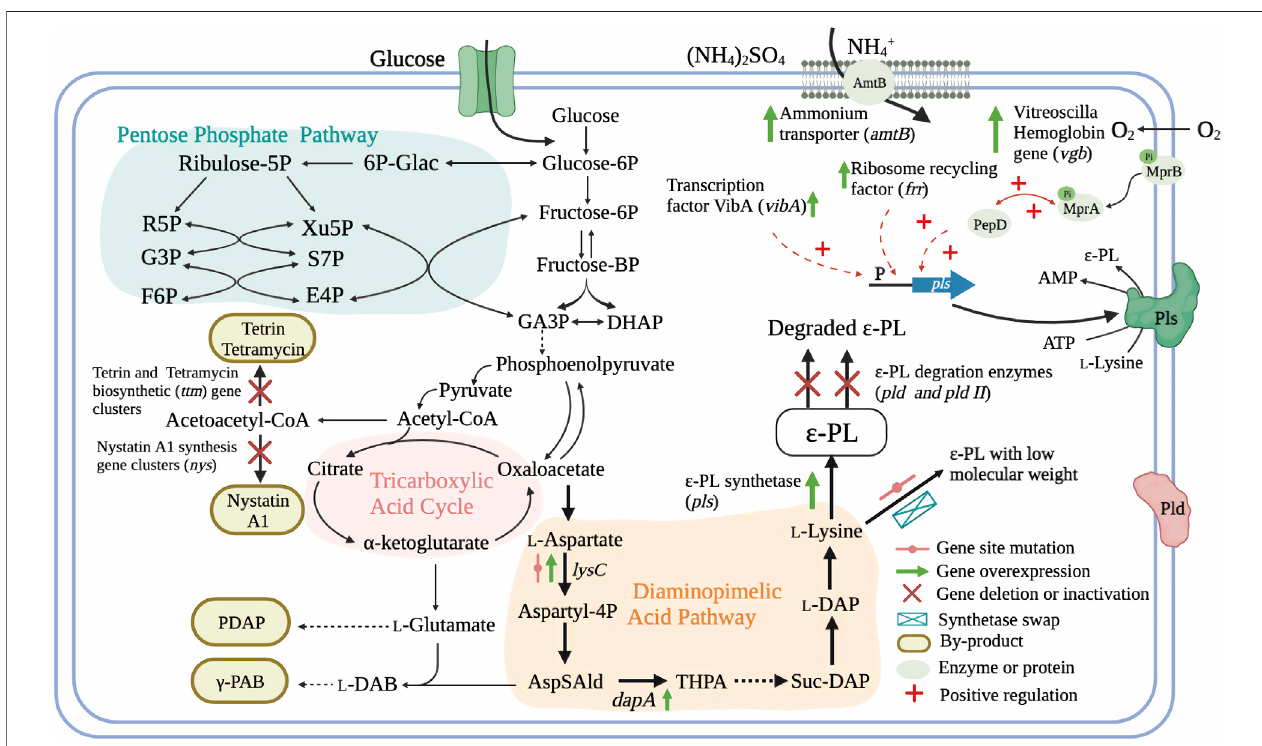
FIGURE 3 | Genetic engineering strategies for the regulation of ε -PL production and molecular weight and in ε -PL-producing Streptomyces and endophytic fungi (Hamanoet al.,2007; Takehara et al.,2008; Yamanaka et al., 2010;Xia et al.,2013; Hamanoet al., 2014;Xuet al., 2015a;XuT. et al.,2018; Liu et al.,2019a;Pan et al., 2019a; Xu et al., 2019; Purev et al., 2020; Wang A. et al., 2020; Yamanaka et al., 2020; Li et al., 2021). AmtB, ammonium transporter; MprA/B and PepD, a signal transduction system; GA3P, glyceratldehyde-3-phosphate; DHAP, dihydroxy acetone phosphate; L-DAB, L-diaminobutanoic acid; γ -PAB, γ -poly-L- diaminobutanoic acid; PDAP, poly-L-diaminopropionic acid; AspSAld, L-Asparte-Semialdehyde; THPA, Hydroxy-tetrahydrodipicolinate; Suc-DAP, Succinyl- diaminoheptanedioate; L-DAP, L-diaminoheptanedioate; ε -PL, ε